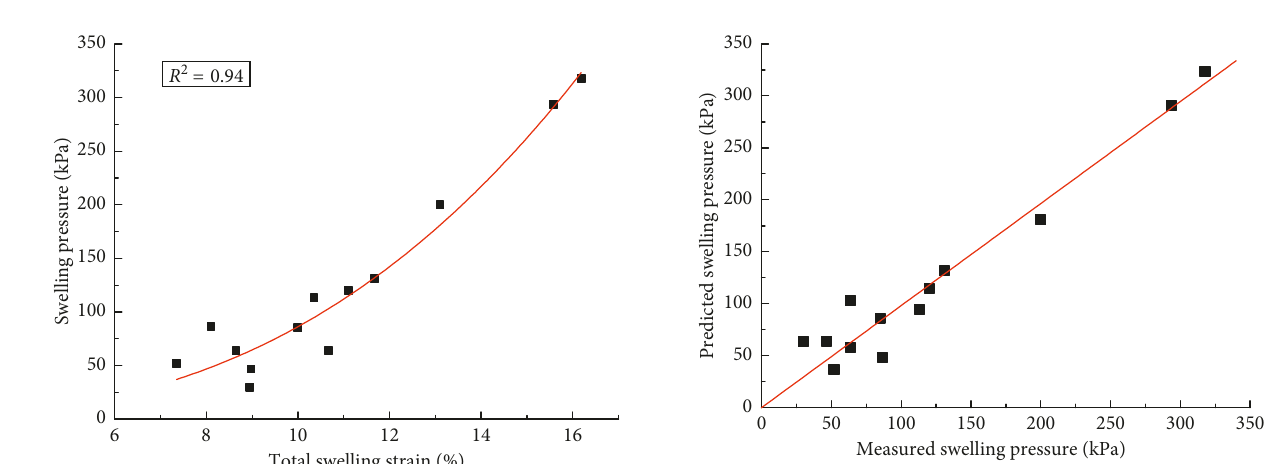
Figure 21: Relation of expansive stress and expansive strain.